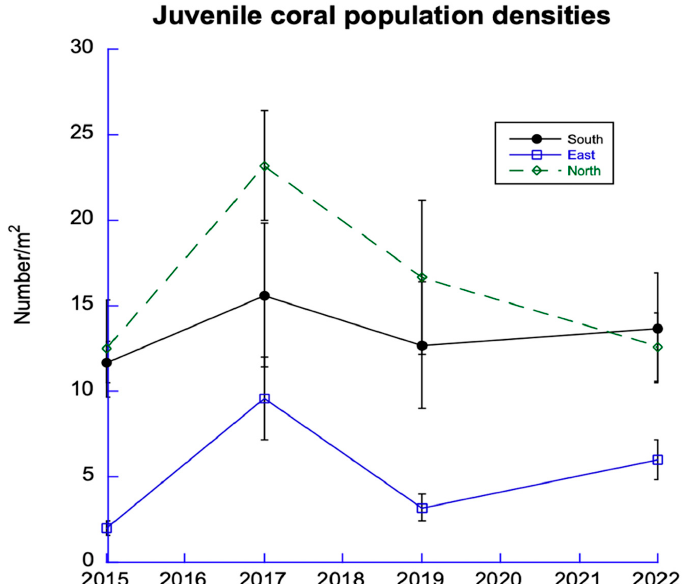
Figure 6. Trends in juvenile corals. Data from 12 sites among 6 DR regions from the 3 sectors.